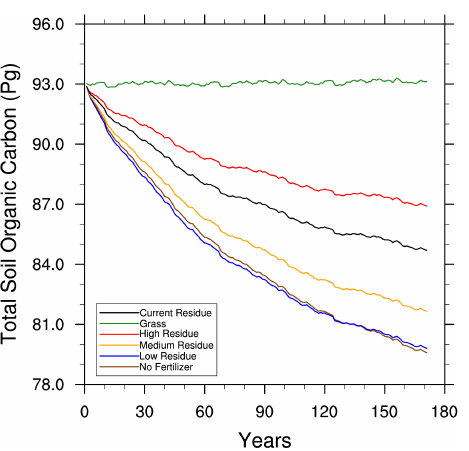
Figure 7. The effect of agricultural land management change on annual crop